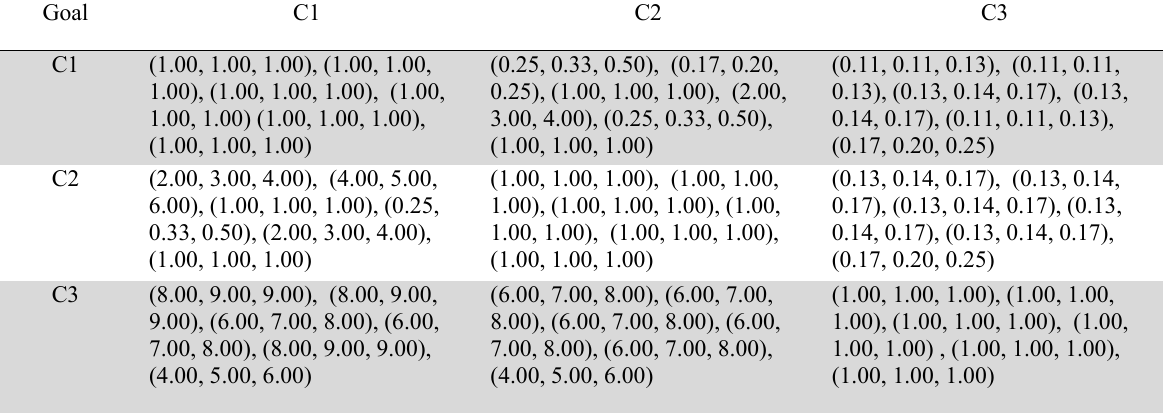
Fig. 11. A hierarchy for selecting location for infectious waste disposal The pair-wise comparison matrix of criteria with respect to goal by the six experts Goal